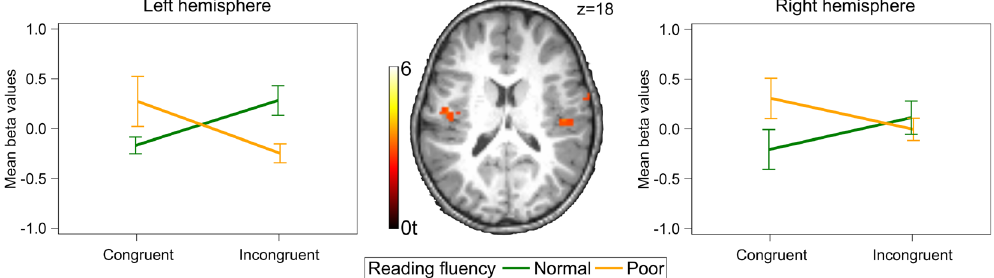
Figure 5. Single-trial EEG-informed fMRI analysis. Mean posterior left-lateralized ERP amplitudes at 382– 442 ms modulated hemodynamic responses in left and right temporoparietal brain regions ( n = 28). Modulation is projected onto a paediatric structural T1 image normalized to MNI space (peak MNI coordinates: left x = − 50, y = − 12, z = 18; right x = 52, y = − 21, z = 12; uncorrected P < 0.005, k ≥ 15). Error bars illustrate standard error of the mean.